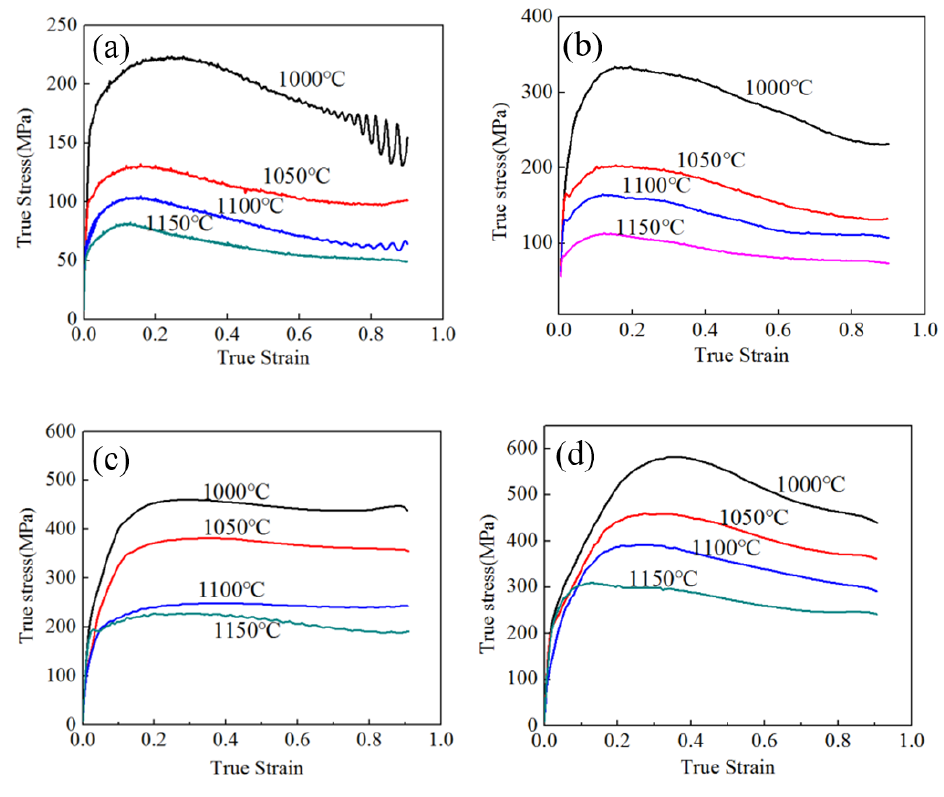
. . . . ε = 0.01 s − 1 ; ( b ) ε = 0.1 s − 1 ; ( c ) ε = 1 s − 1 ; ( d ) ε = 10 s − 1 .